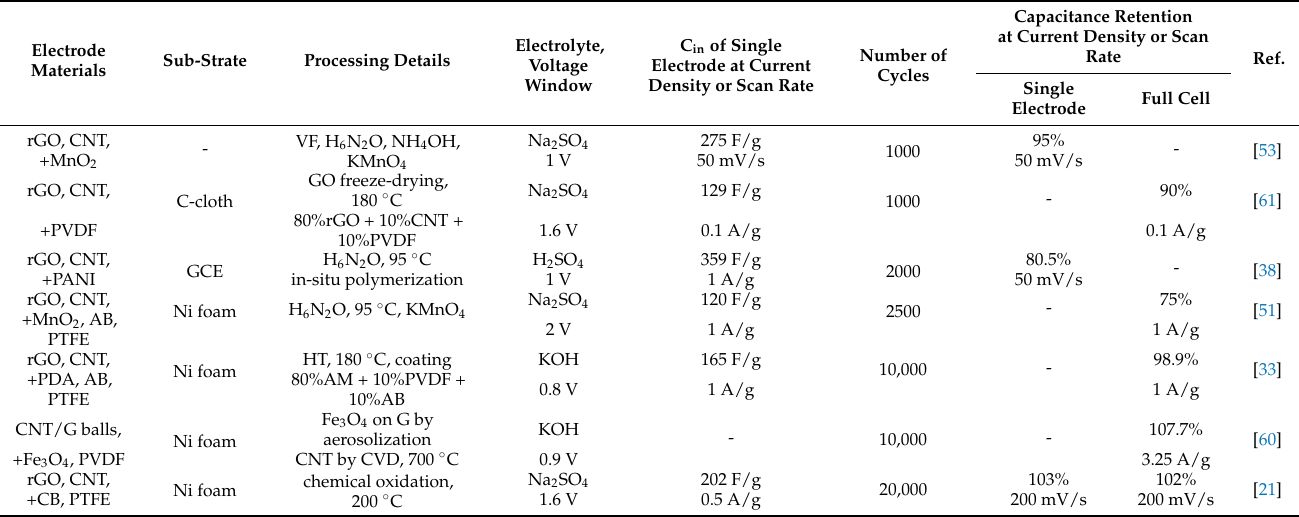
Table 2. Values of the initial specific capacitance (C in ) of G/rGO-CNT-based single electrodes measured in three-electrode configuration before long-term test and capacitance retention after long cycling (ordered with number of cycles increase) reported for G/rGO-CNT-based single electrodes as well as for full devices using